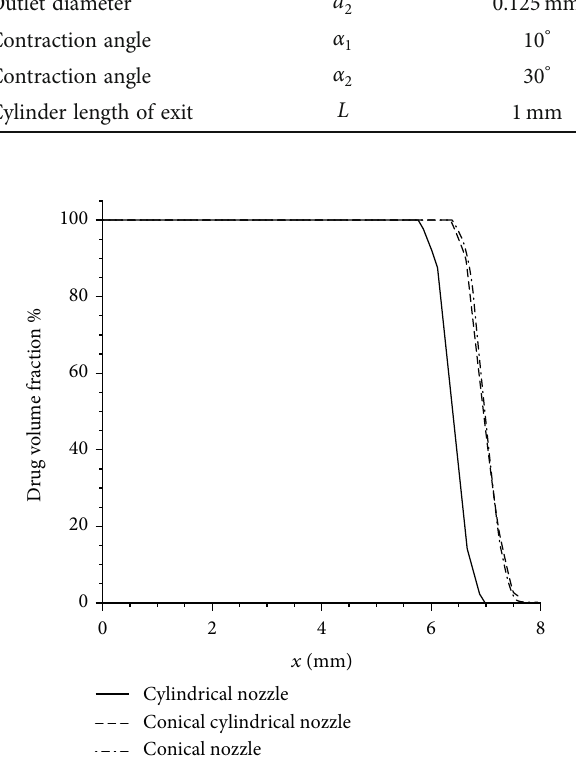
Figure 6: Changes of drug volume fraction with depth in the subcutaneous tissue.